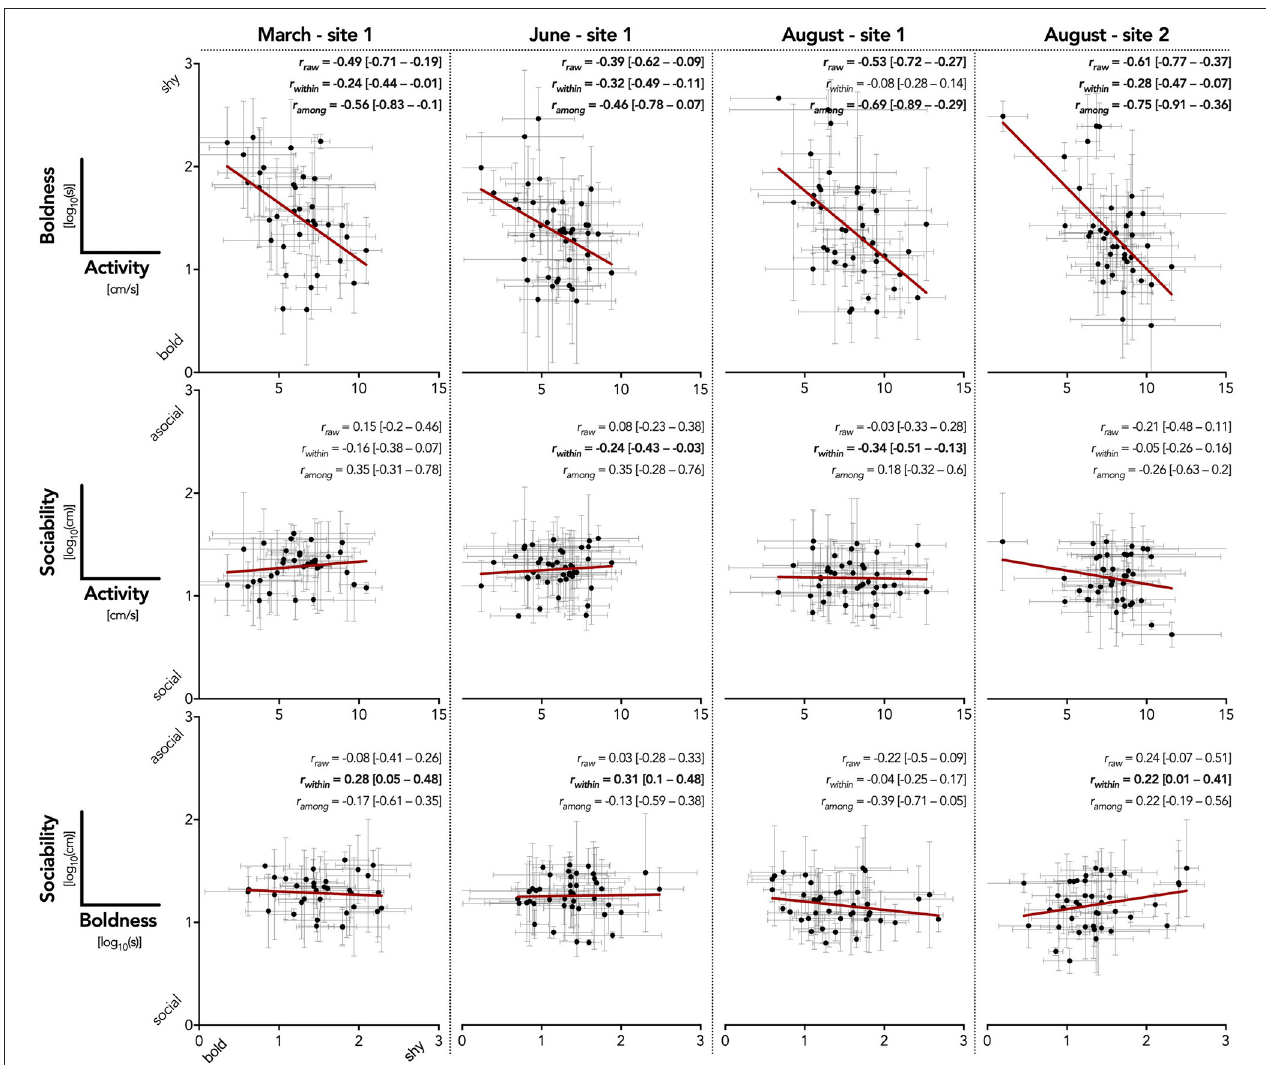
FIGURE 4 | Correlations between behavioral traits across temporal and spatial scale. Mean trait scores ( ± SD) of individual test fish are shown for each population. Linear regressions (red line) and mixed model estimated correlation coefficients visualize the relationships between traits (parameters significantly different from zero at the 95% confidence level are indicated in bold; see main text for detailed analysis). Note that for boldness and sociability lower values indicate a high trait